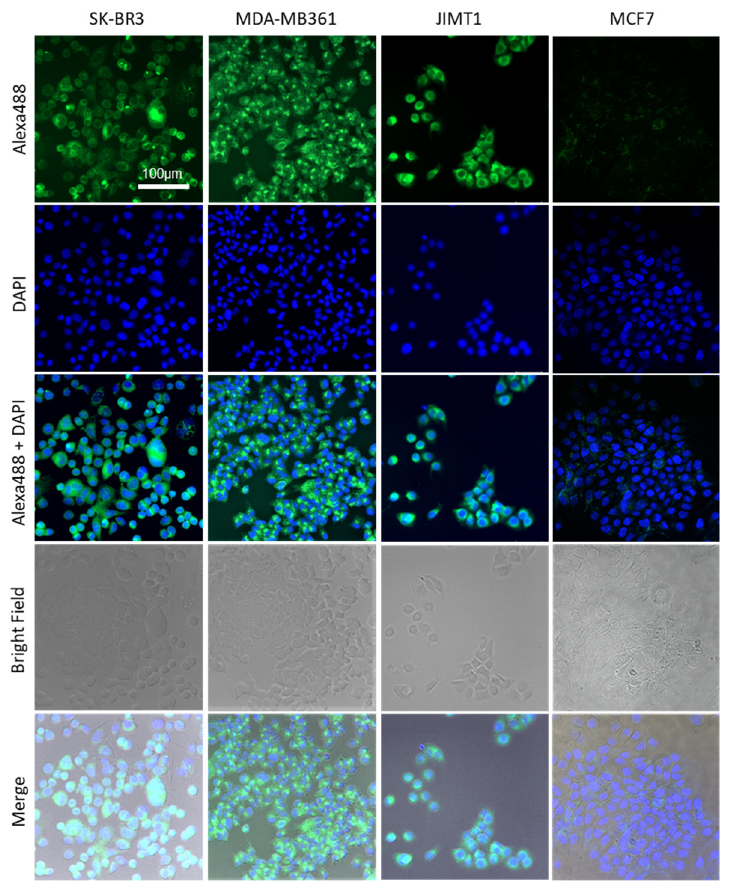
Figure 1. Immunocytochemistry of HER2 protein in breast cancer cell lines (SK-BR3, MDA-MB361, JIMT1, and MCF7). SK-BR3 cells, MDA-MB361 cells, and JIMT1 cells exhibited stronger fluorescent signals than MCF7 cells, in which HER2 expression was virtually undetected. Scale bar: 100 µm.